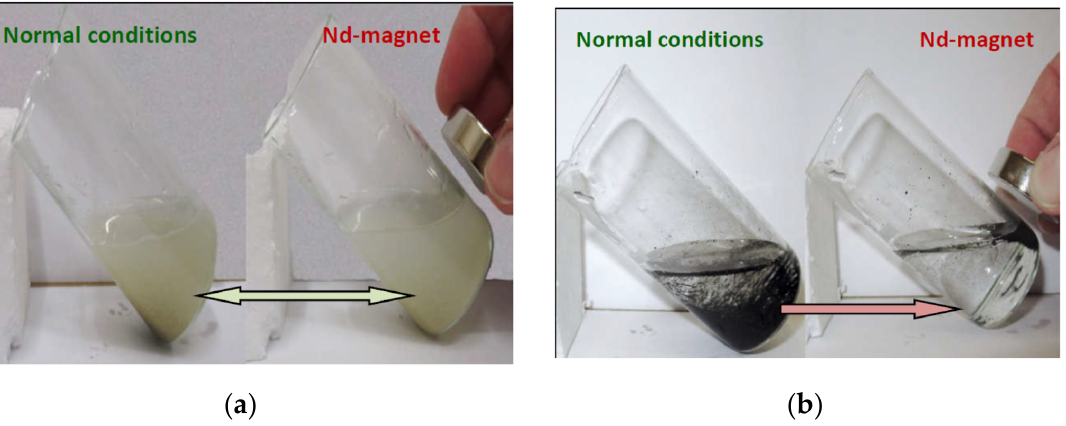
Figure 5. Suspensions of the investigated sorbents in an equilibrium formaldehyde solution in the presence and absence of an external magnetic field (Nd magnet): ( a )suspension of Bt sample; ( b )suspension of Bt-10F composite sample.